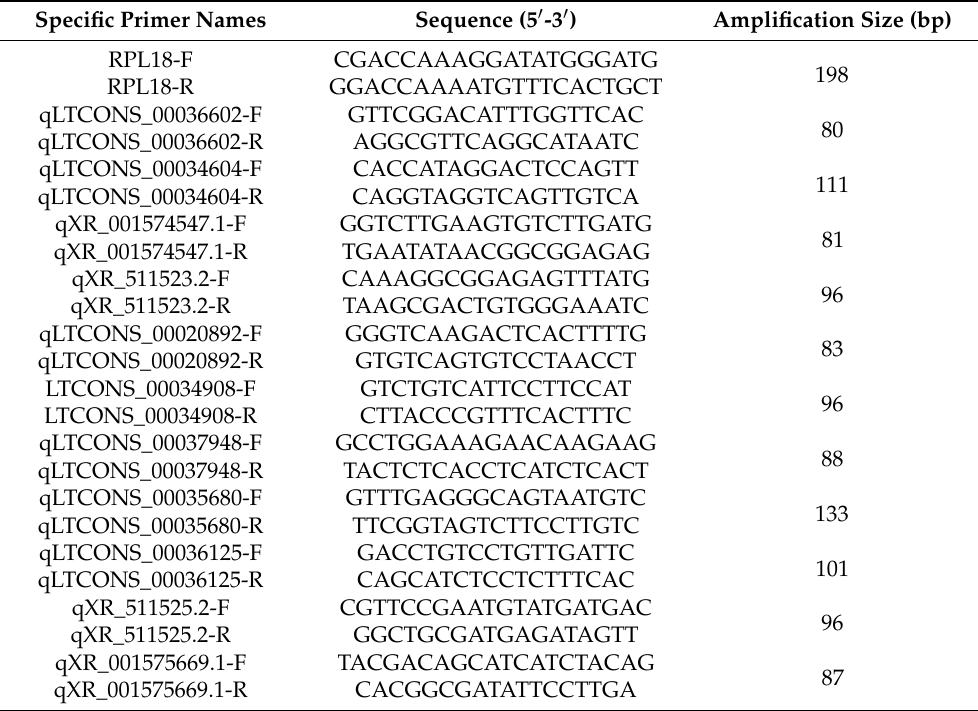
Table 1. Primers of lncRNAs used for RT-qPCR in Tribolium castaneum . Specific Primer